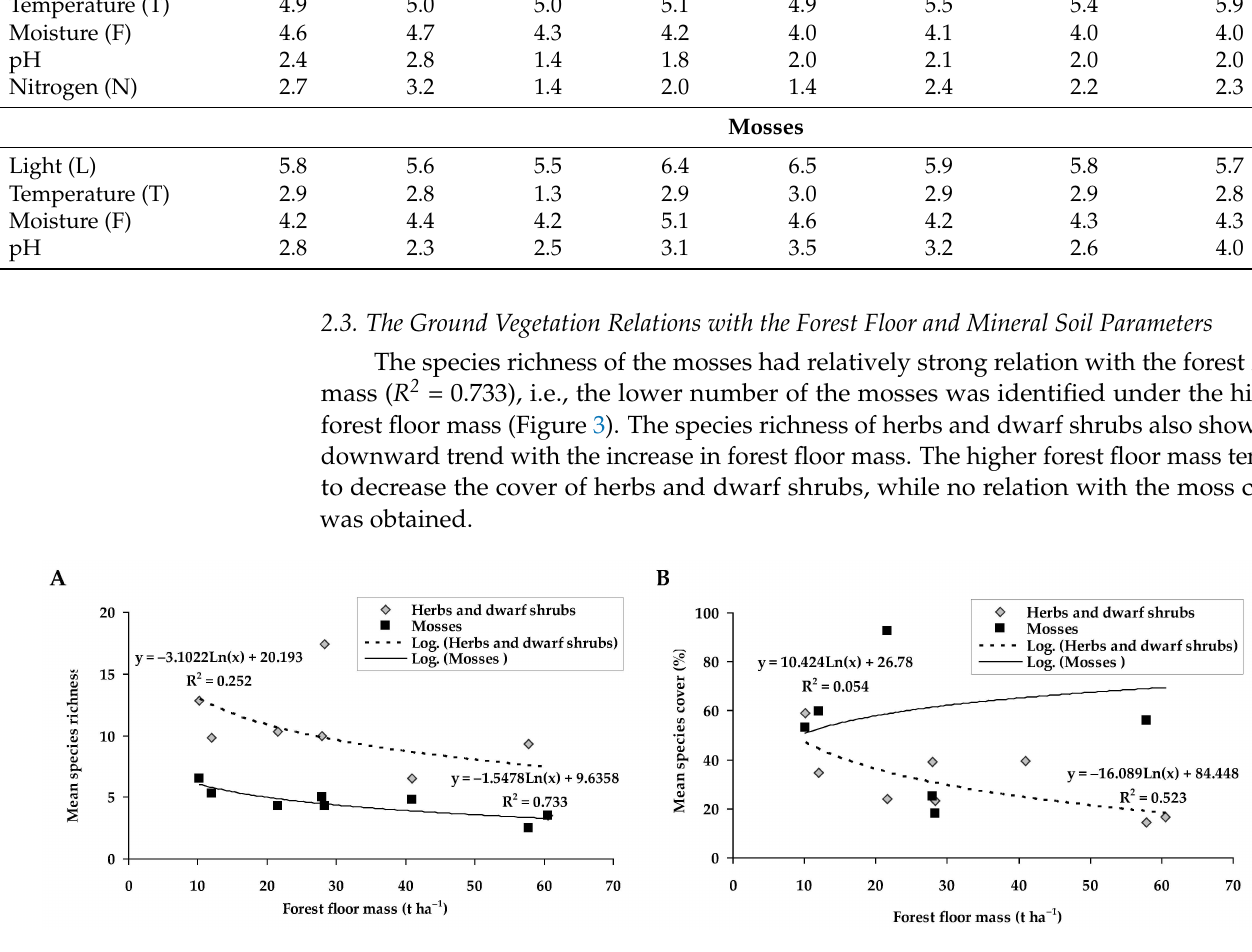
Figure 3. Relations between species richness ( A ) and cover ( B ) of herbs and dwarf shrubs and mosses with the forest floor mass; p ≤